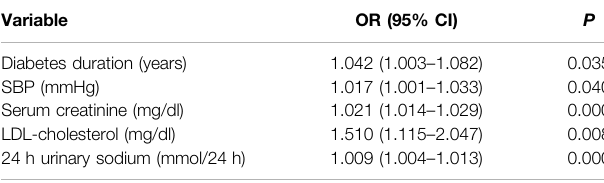
TABLE 2 | Multivariable-adjusted ORs and 95% CIs for patients with albuminuria.